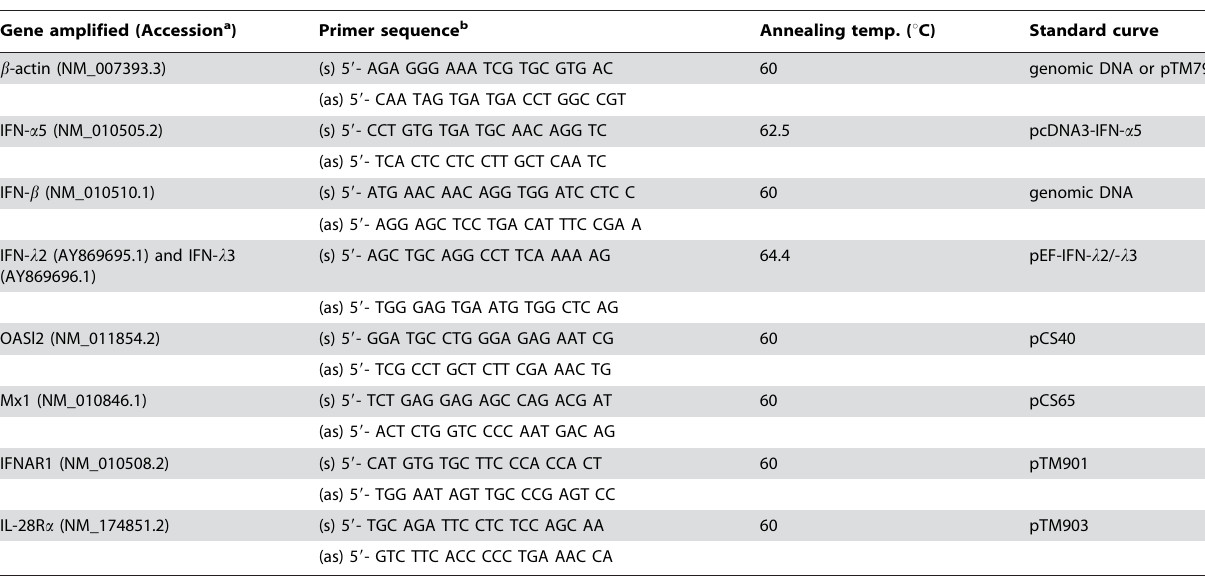
Table 1. Primers sequences and PCR conditions used.